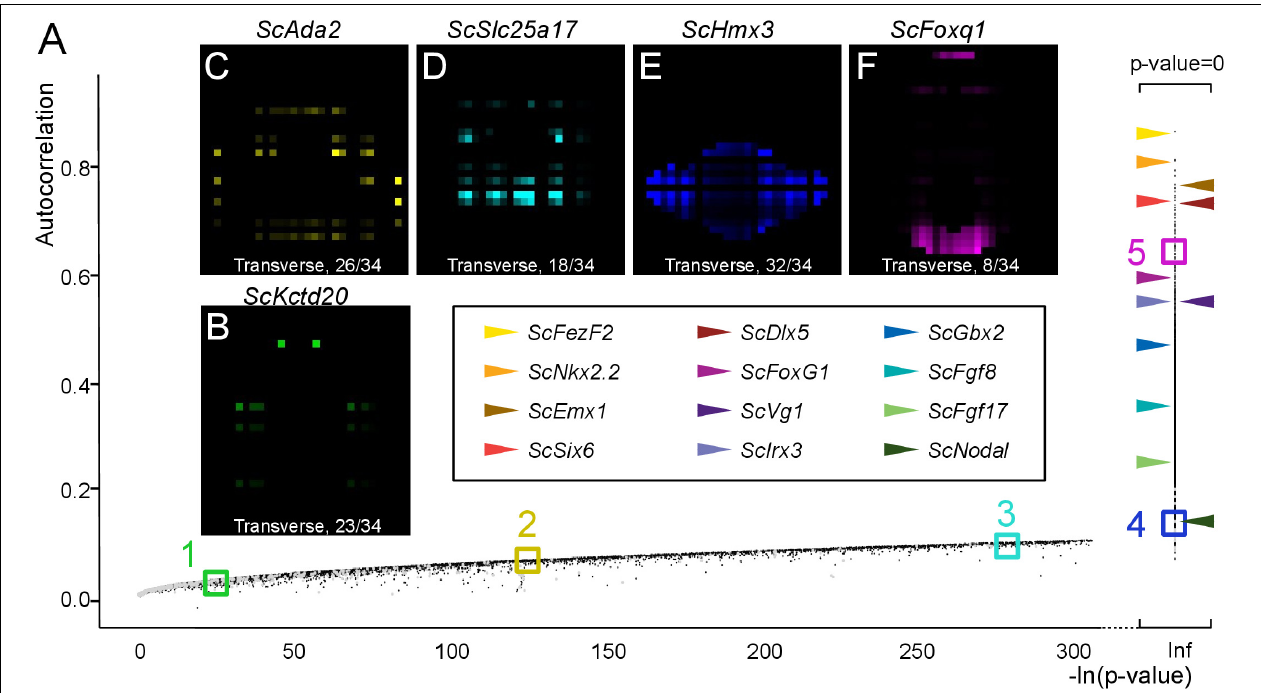
FIGURE 6 | Autocorrelation as an indicator of profile regionalization. (A) Graph showing autocorrelation values (y-axis) and their statistical support [-ln( p -value) on x-axis] for all gene models. Each dot corresponds to a single gene model, in gray if the corresponding total digital expression is below 100, otherwise in black. Gene models with null p -values are shown on the right of the graph with –ln( p -value) = infinite (Inf). Horizontal arrowheads point to dots corresponding to a selection of genes, exhibiting clearly regionalized expressions in ISH experiments. Color codes for these genes are shown boxed in black. Colored boxes delimit sectors of the graph numbered from 1 to 5 and containing gene models with decreasing p -values/increasing autocorrelations (green, sector 1; yellow, sector 2, cyan, sector 3; blue, sector 4; magenta, sector 5). (B–F) Digital transverse sections showing examples of profiles observed in sectors 1 (B) , 2 (C) , 3 (D) , 4 (E) , and 5 (F) . The corresponding gene identities are indicated and sections are numbered from posterior to